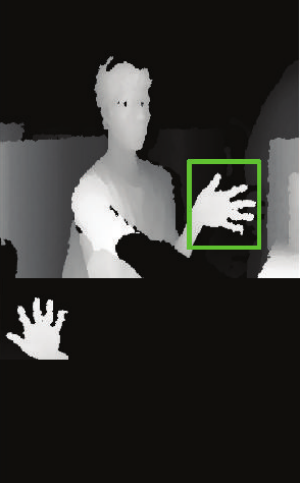
Figure 7: Binary image of the palm.